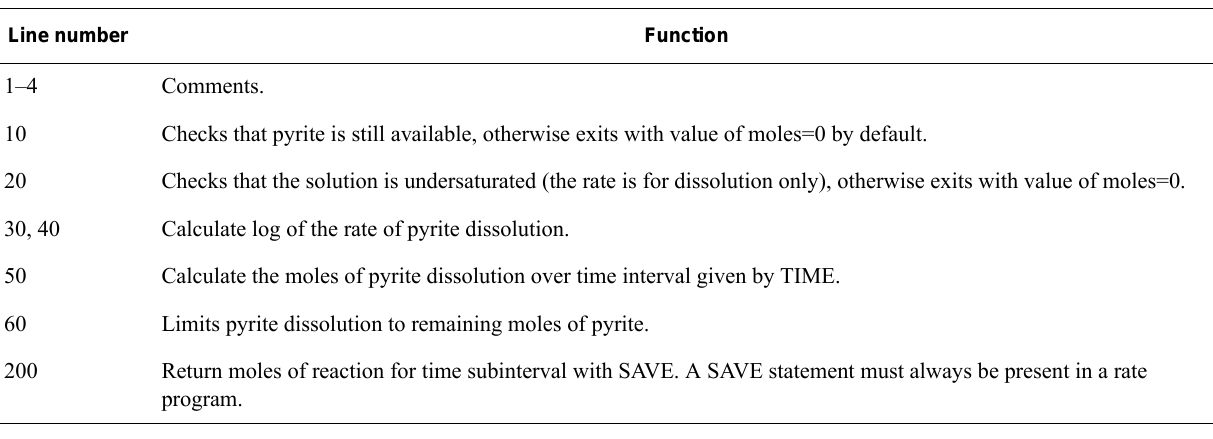
Table 6. Description of Basic program for pyrite dissolution kinetics given in example for RATES data